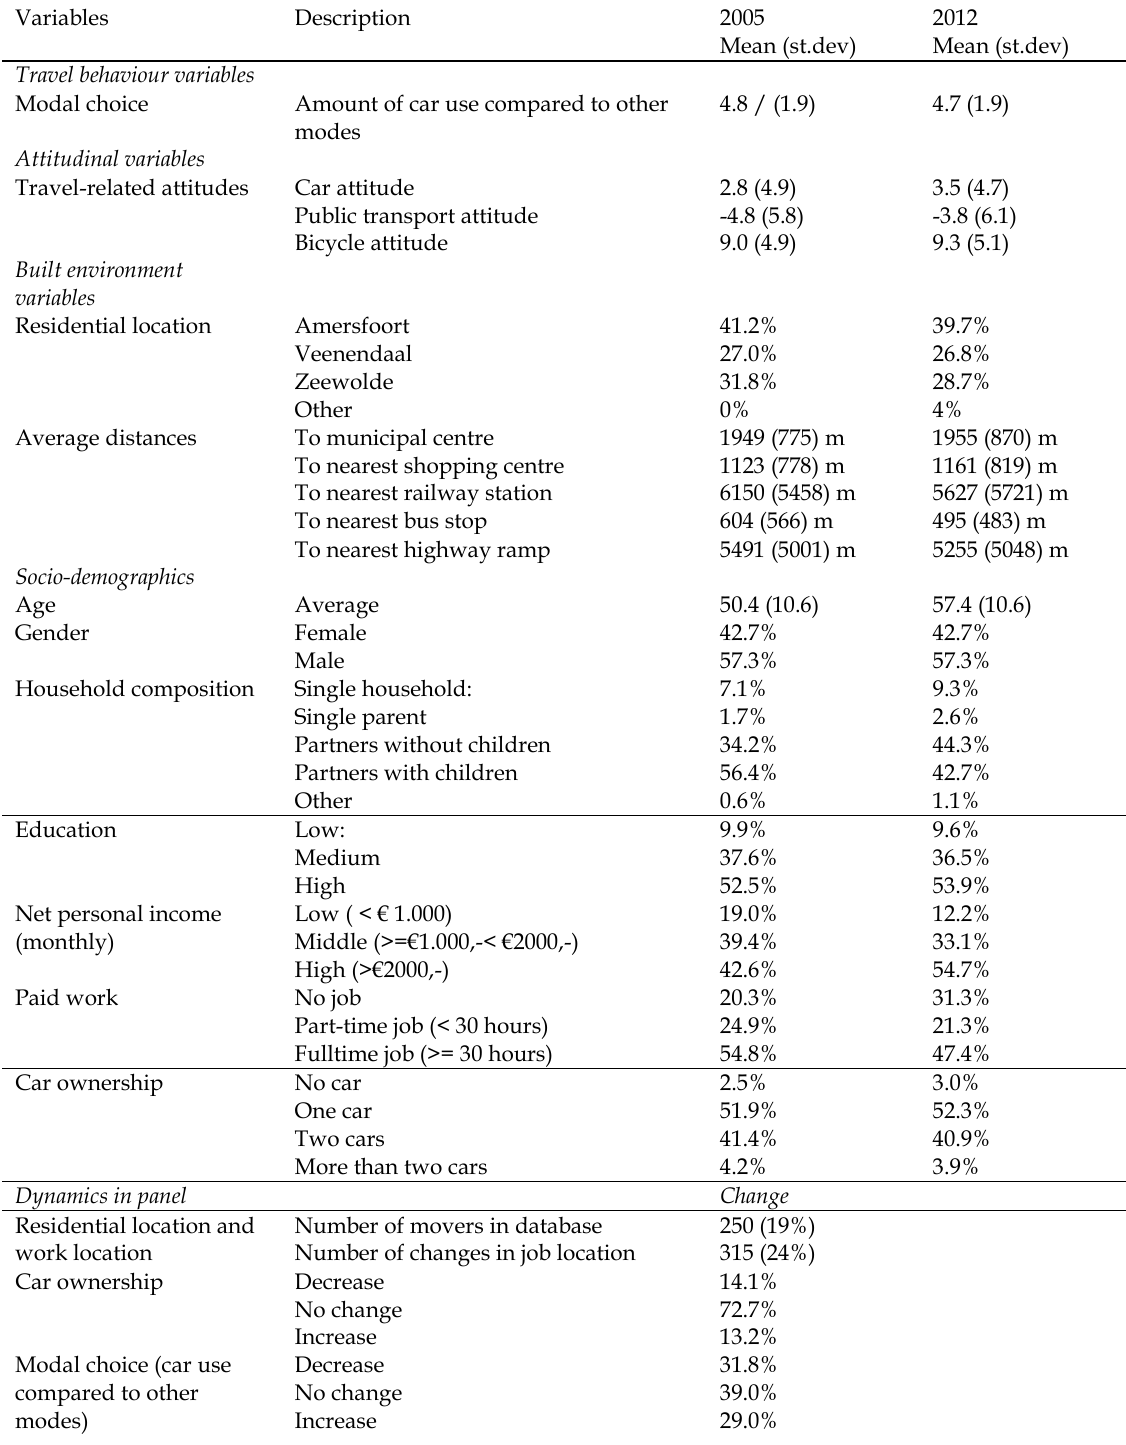
Table 1. Key variables in 2005 and 2012